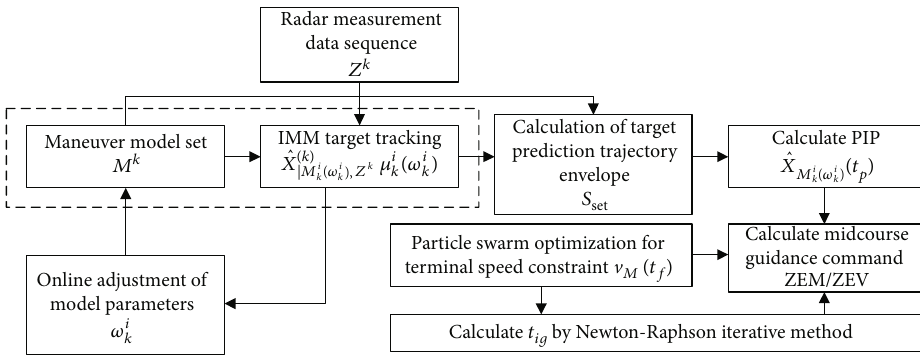
Figure 4: Logic diagram of midcourse guidance considering predictions of the trajectory for maneuver NSGVs.